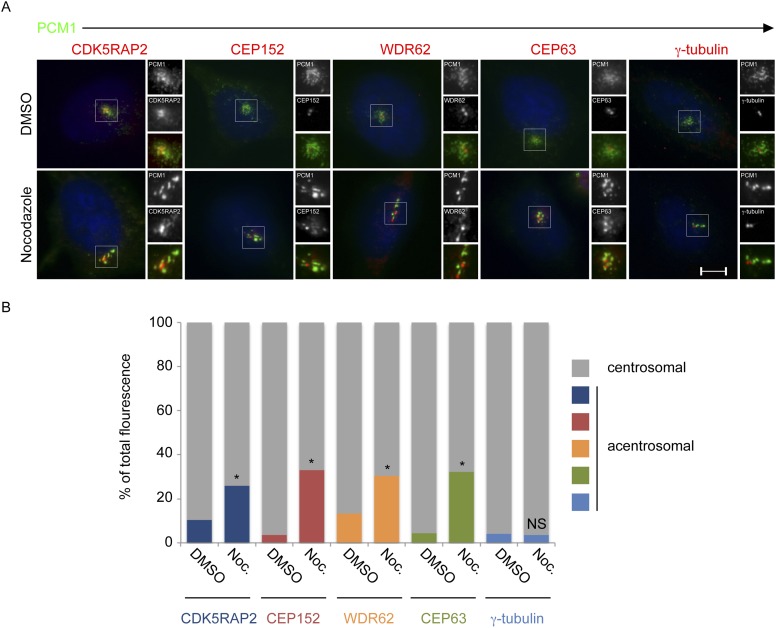
CDK5RAP2, CEP152, WDR62 and CEP63, but not γ-tubulin, localize to the centrosome in a microtubule-dependent manner.(A) HeLa cells treated with DMSO or 17 μM nocodazole were analyzed by immunofluorescence for PCM1 (‘p’, green), CDK5RAP2 (red), CEP152 (red), WDR62 (red), CEP63 (red) and γ-tubulin (red). Scale bars indicate 5 μm for all images. (B) Quantification of the relative mean fluorescence intensities of CDK5RAP2, CEP152, WDR62, CEP63 and γ-tubulin at the centrosome (gray) and acentrosomal (as defined by colocalization with the centriolar satellite component PCM1; blue, red, orange, green and teal) in DMSO or nocodazole-treated cells. For all quantifications, 15 cells were analyzed per experiment (n = 3). p < 0.005 (paired t-test) statistically significant differences from DMSO-treated controls are denoted by an asterisk.